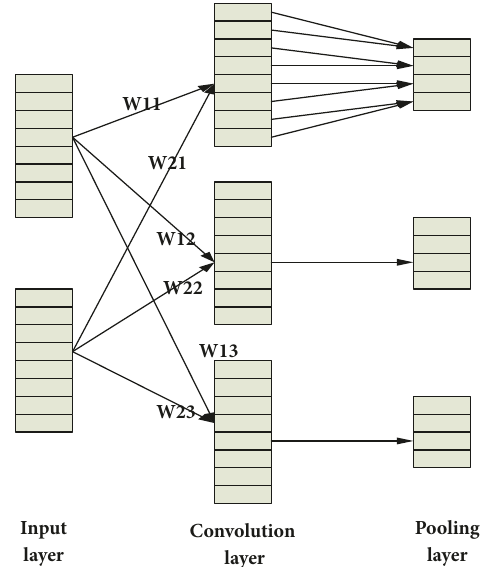
Figure 2: Illustration of a convolution layer and the subsequent pooling